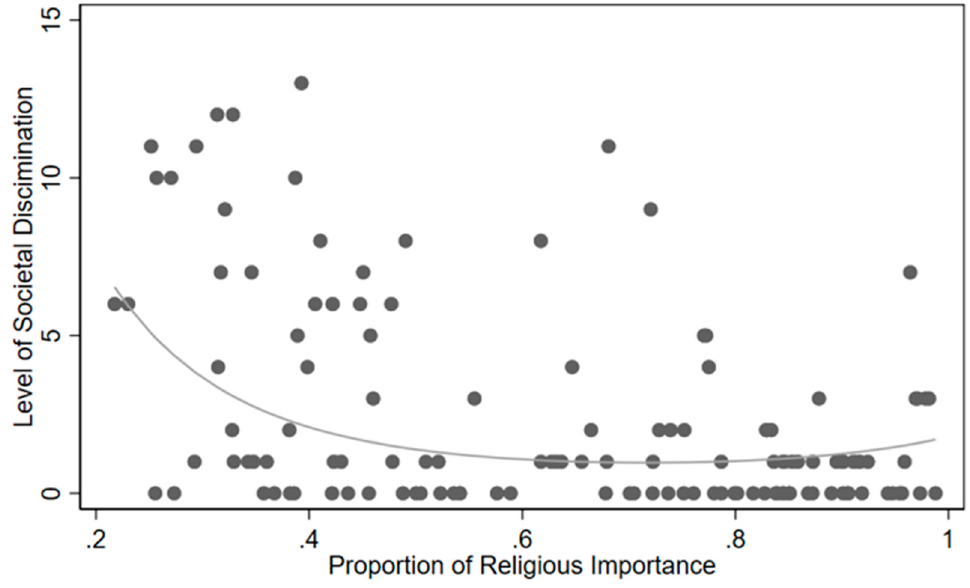
Figure 1. The Relationship between Religions Importance and the level of Societal Discrimination of Muslim Minorities in Christian Majority Countries.